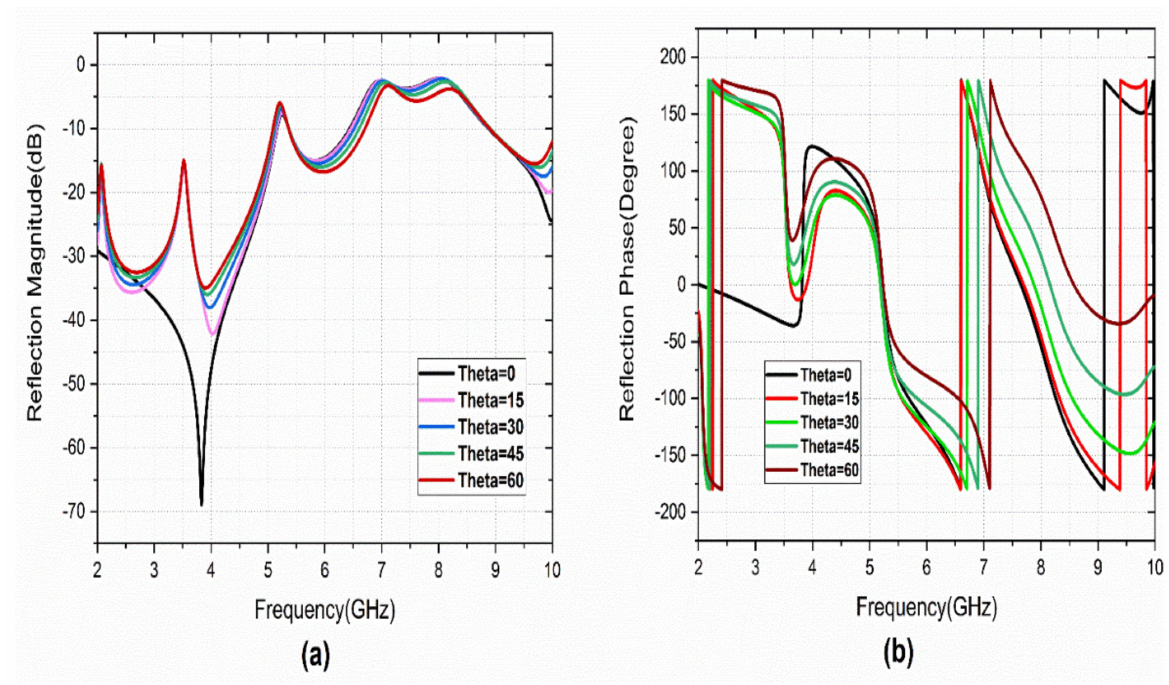
Figure 6. S 21 variation with Theta variation: ( a ) magnitude, ( b ) phase.